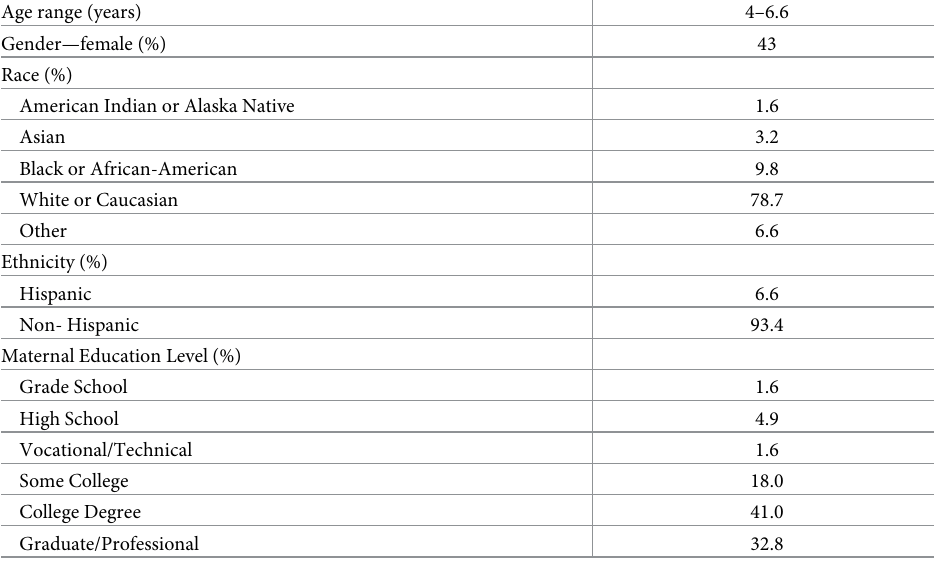
Table 1. Demographics of subjects participating in the